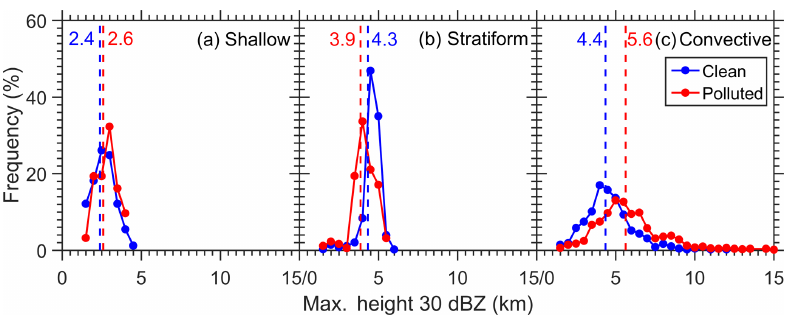
Figure 7. Occurrence frequencies (OF) of top height that the 30dBZ radar echo can reach of (a) shallow, (b) stratiform, and (c) convec- tive precipitation. Data are from TRMM PR retrievals made during 2007–2012. Red and blue colors represent polluted and clean cases, respectively. Vertical lines represent the corresponding average value of the top heights. Table 3. Statistics describing the mean top height that 30dBZ radar echoes can reach under polluted and clean conditions for different precipitation regimes. The numbers in italics indicate that the differences between polluted and clean conditions are statistically significant at the 95% confidence level according to the two-tailed Student’s t test. Precipitation No. of clean No. of polluted Ave. top height Ave. top height Abs. ( T ) for regime profiles profiles of clean 30dB of polluted 30dBZ a = 0 . 05 Z echoes (km) echoes (km) Shallow 165 31 Stratiform 1089